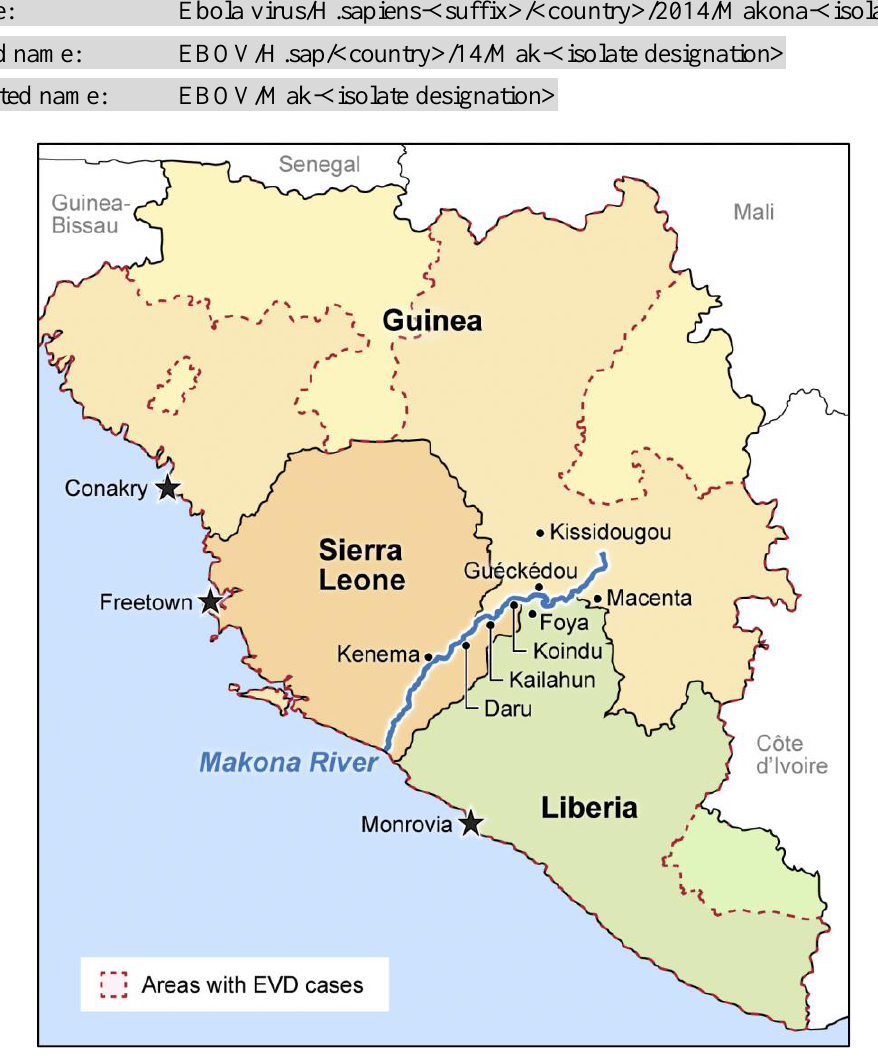
Figure 1. Location of the Makona